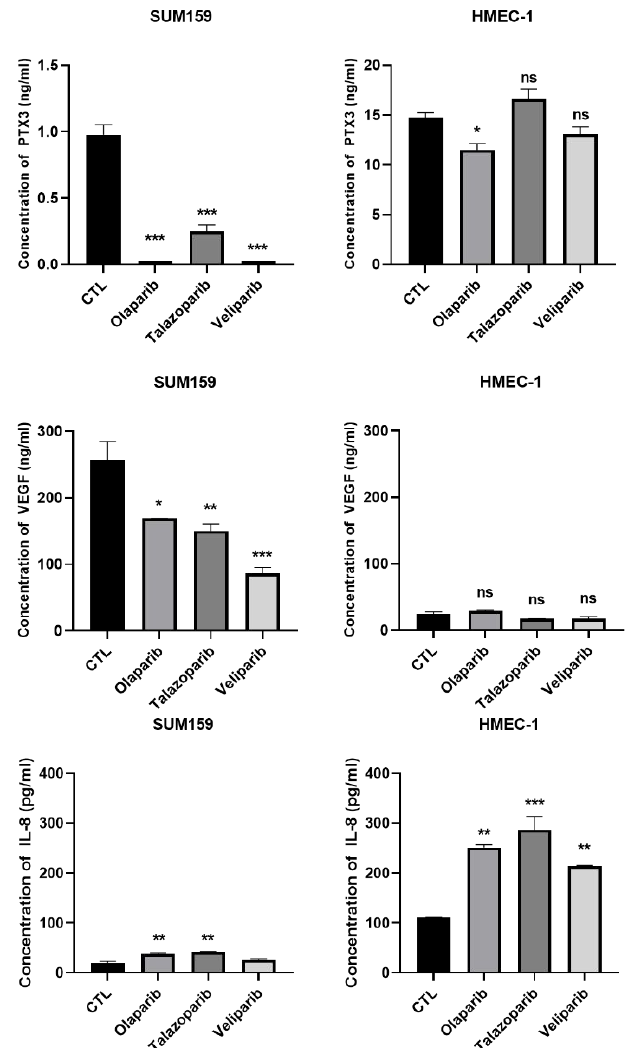
Figure 3. PARPi modifies the secretion of the angiogenesis-related proteins PTX3 and VEGF. ( A ) Cells were treated for 72 h with olaparib at 20 µM and, after the overnight incubation without SVF, a serum-free conditioned medium was applied onto the human angiogenic array membranes. The boxes indicate the major angiogenic regulated-molecules. ( B ) PTX3, VEGF, and IL-8 concentrations in the supernatant of SUM159 and HMEC-1, were measured by ELISA after 72 h of treatment by olaparib (20 µM), talazoparib (10 nM), and veliparib (20 µM). * p < 0.05; ** p < 0.01; *** p < 0.001; ns: no specific.